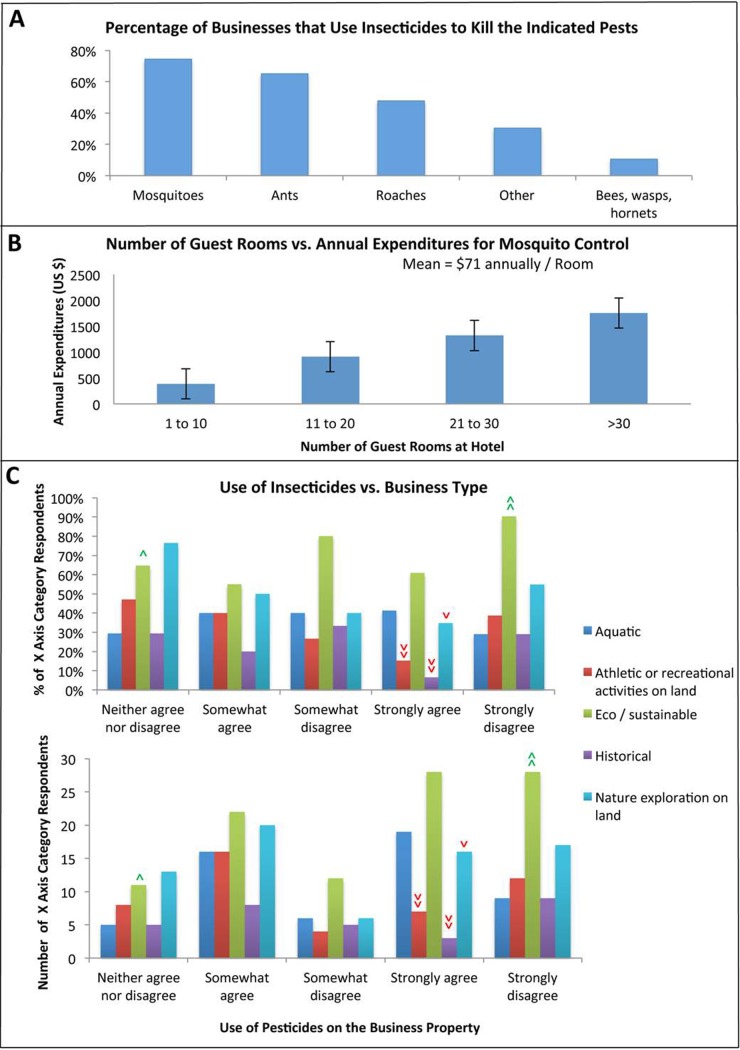
Purchase and use of insecticides.A) The percentage of insecticide-using businesses that use insecticides to kill the indicated pests. Count numbers are reported in Table 4. B) Survey-taker reported data on annual expenditures for mosquito control (converted to U.S. dollars) plotted as a function of the number of guest rooms available for rent. Annual expenditures increase as the number of rooms increases (p<0.00001). Mean = $71 spent on mosquito control per room annually. C) Likert-scale responses from representatives of the indicated types of businesses regarding the use of insecticides on their properties. The percentages (graph at top) and numbers (lower graph) of the X-axis category respondents providing the answers indicated are shown. >>> = very highly significant, >> = very significant, > = significant, with green corresponding to a higher than expected percentage/number of respondents for a given X-axis category and red corresponding to a lower than expected percentage/number of respondents for a given X-axis category. See text for additional details regarding statistical analyses and a discussion of significant results.